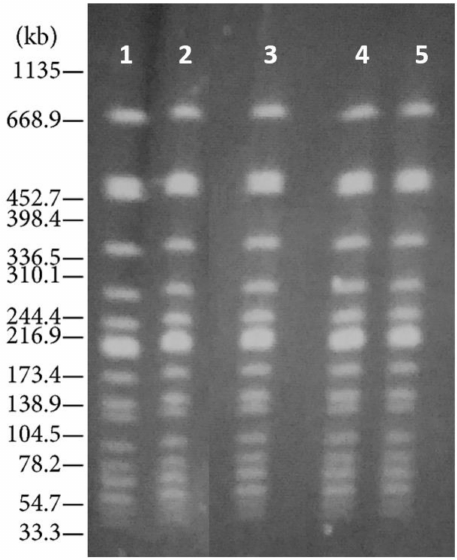
Figure 3. Pulse Field Gel Electrophoresis of L. monocytogenes isolates based on the use of the restriction enzyme ApaI. Line 1= Human isolate; Lines 2 and 3= Foodborne isolates; Lines 4 and 5= Environmental isolates. Salmonella branderup H9812: Molecular